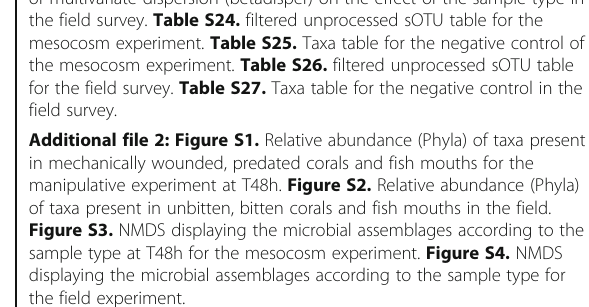
Figure S3. NMDS displaying the microbial assemblages according to the sample type at T48h for the mesocosm experiment. Figure S4. NMDS displaying the microbial assemblages according to the sample type for the field